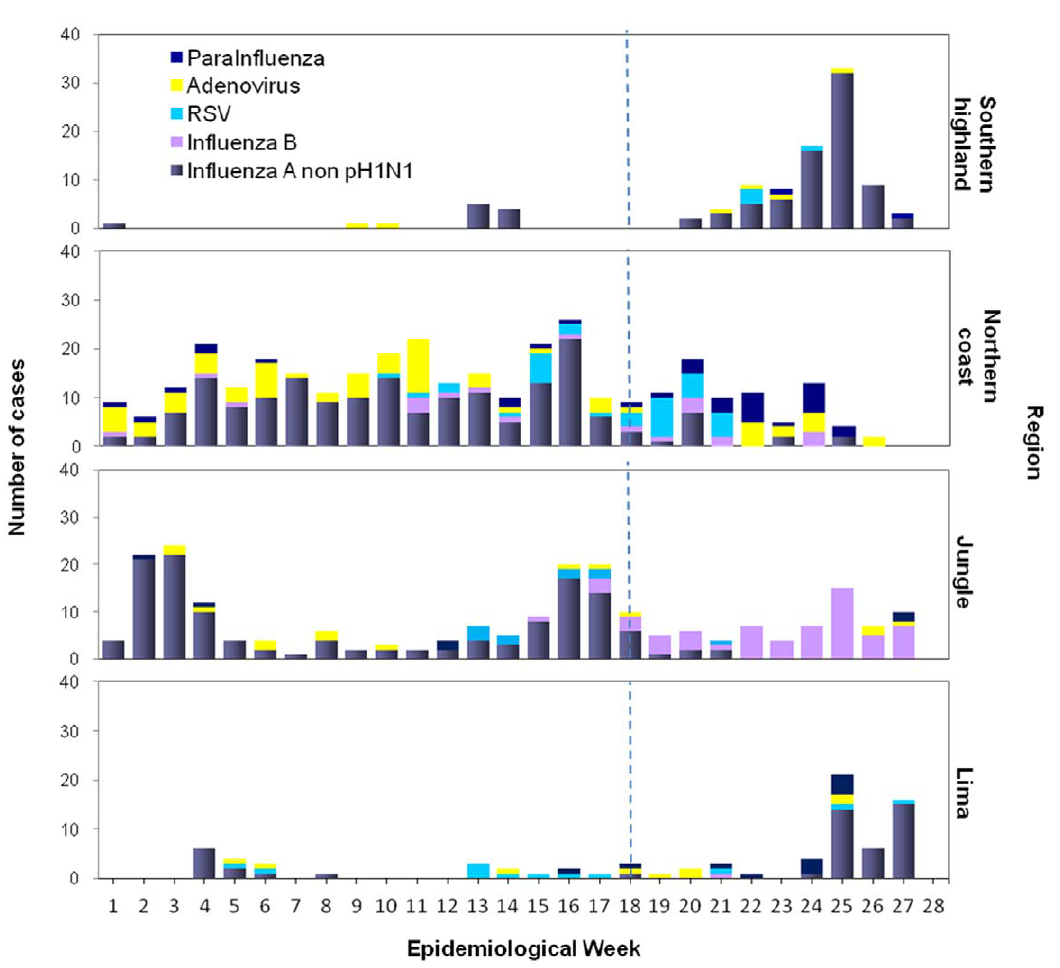
Figure 2. Distribution of viral etiology among regions according to epidemiological week. Peru, January 4 to July 13, 2009.